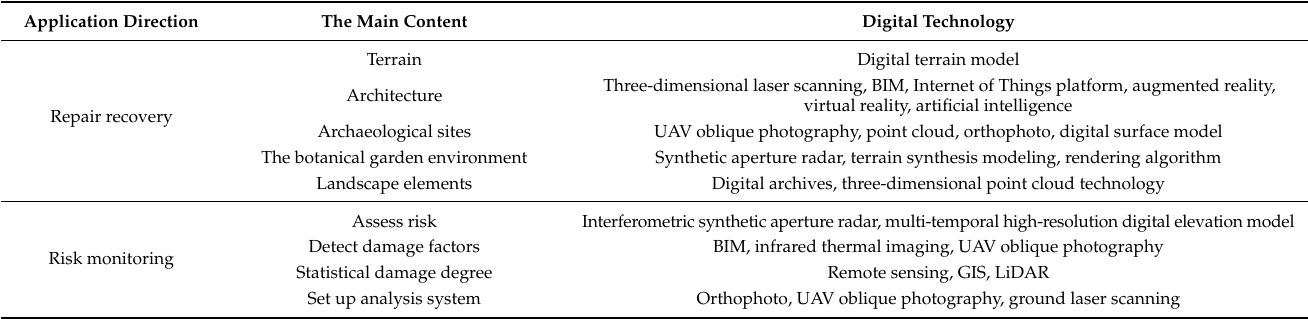
Table 4. Application of digital technology in landscape architecture heritage